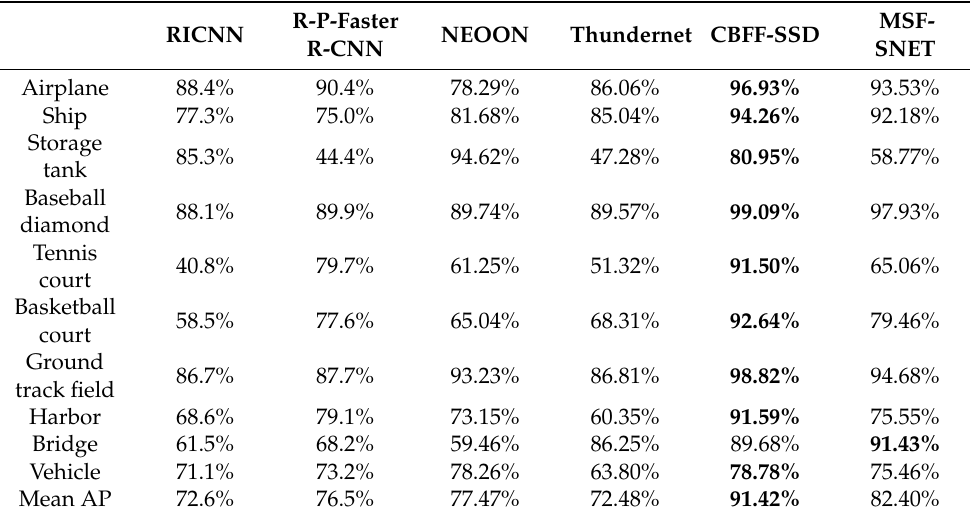
Table 3. Performance comparison of different algorithms on NWPU-VHR-10 dataset.